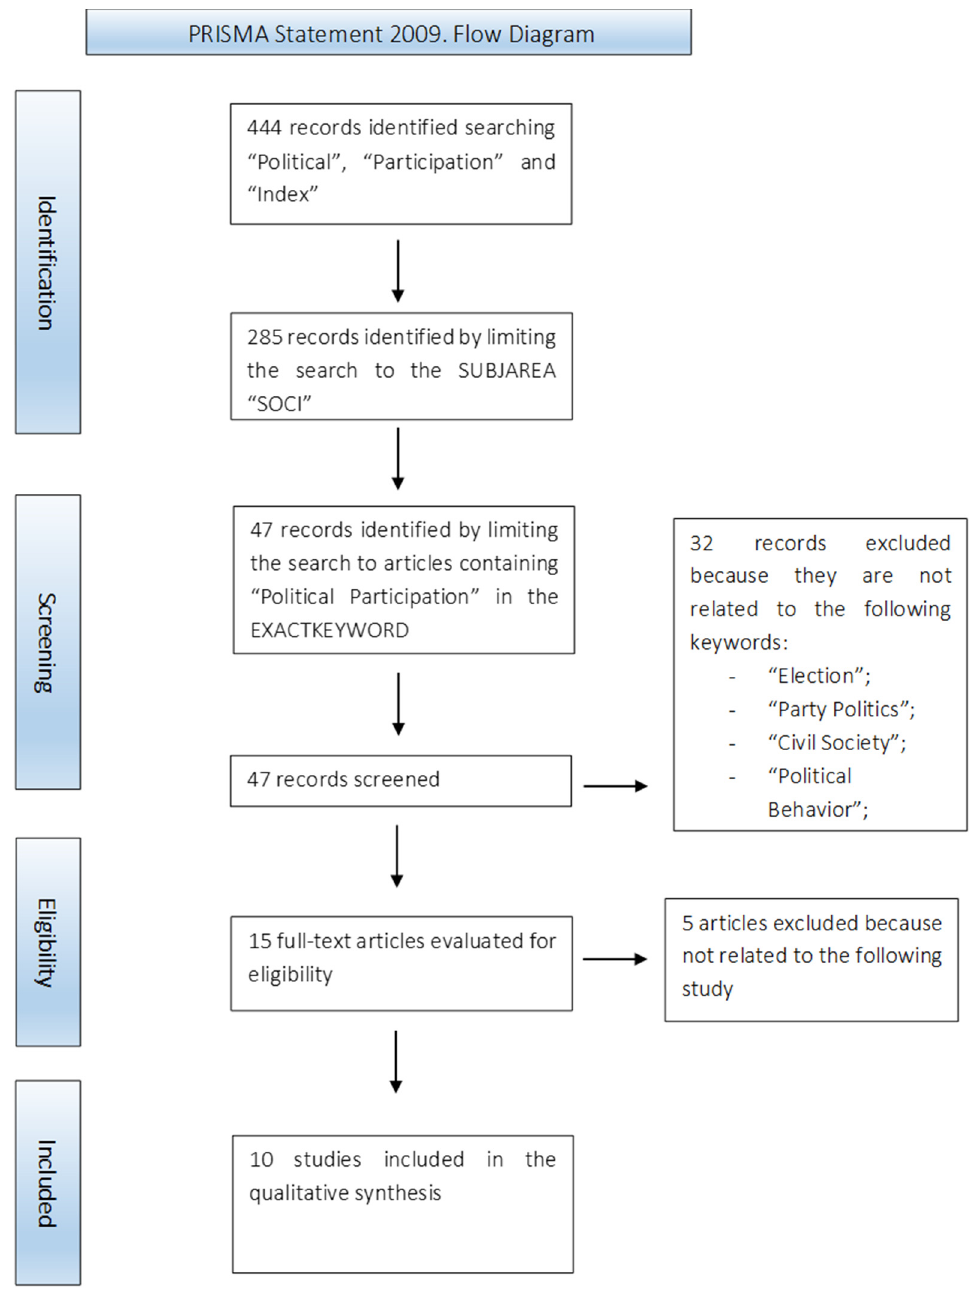
Figure 1. PRISMA statement 2009. Flow diagram: political participation.